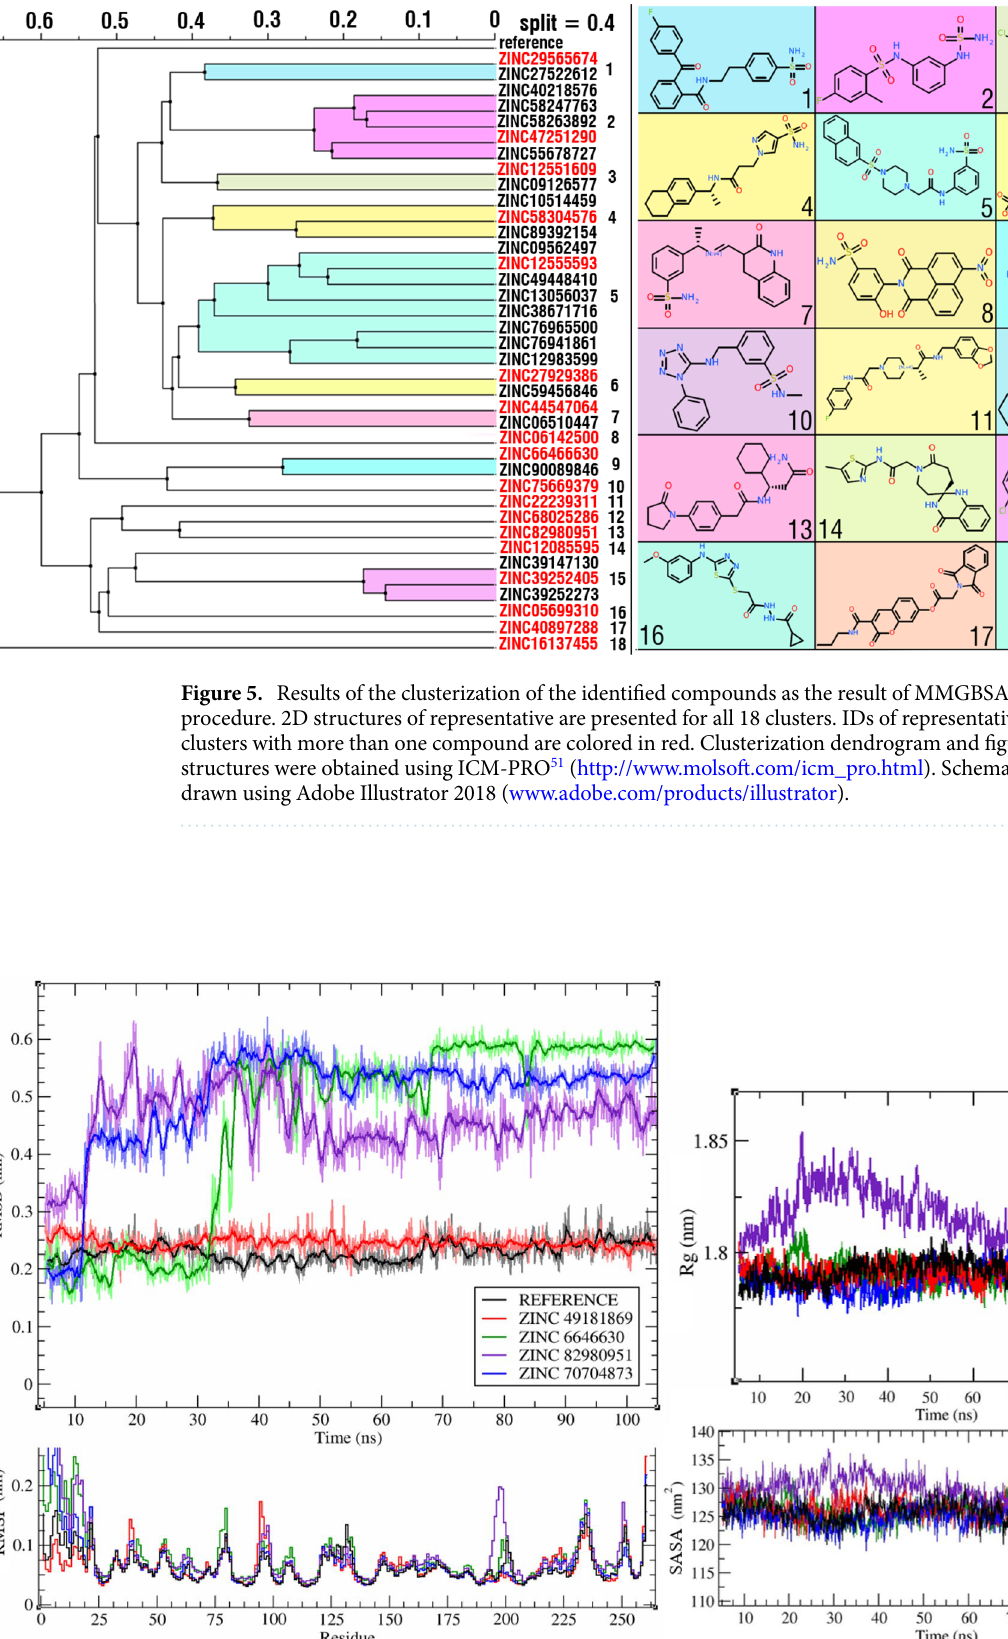
Figure 6. RMSD values of studied compounds and Rg, RMSF and SASA values of hCA XII during performed MD simulations. First 5 ns represent equilibration stage of performed MD